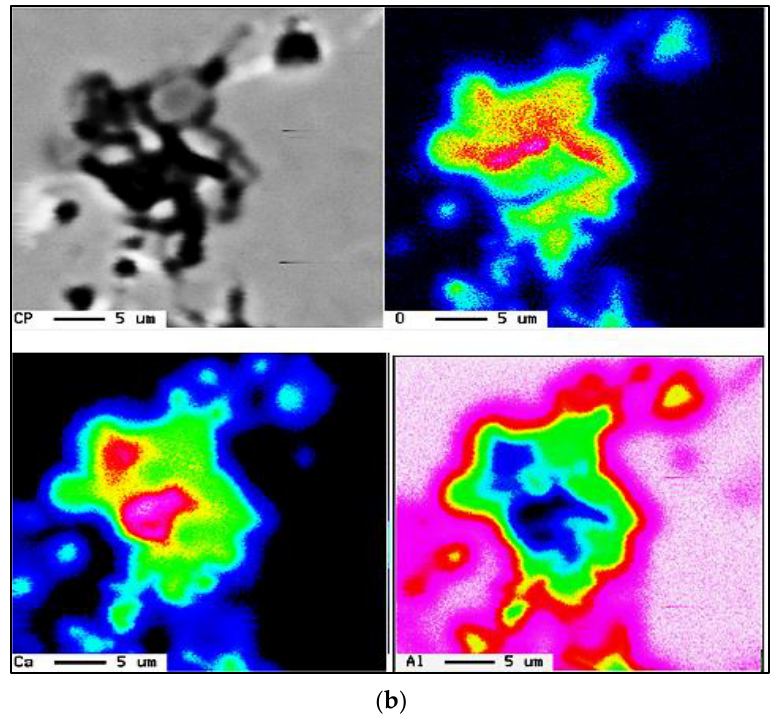
Figure 8. Examples of ( a ) Bi – Sr – Mg – O interactions, ( b ) X-ray mapping of Al-Ca-O particles in the captured picture (CP) shown in ( b ) — see Figure 5f.